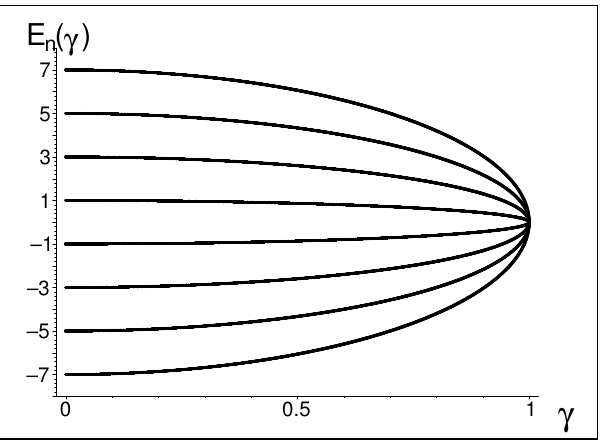
Figure 1. Spectrum (3) for N = 8 and its BEC degeneracy at γ =